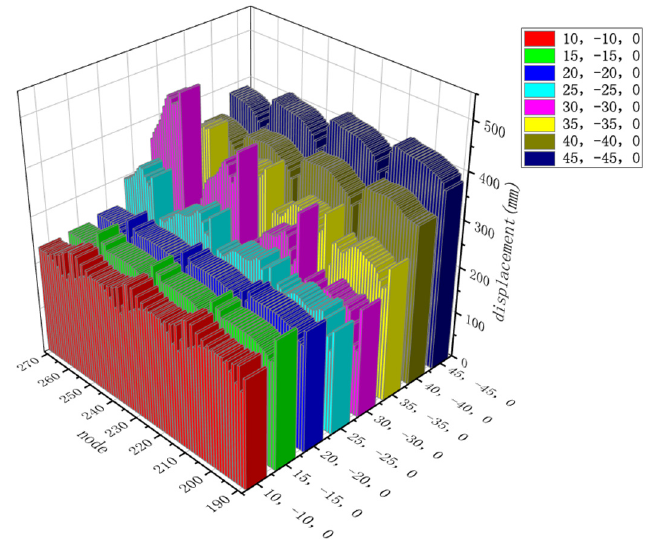
Figure 10. Node displacement diagrams at different angles.